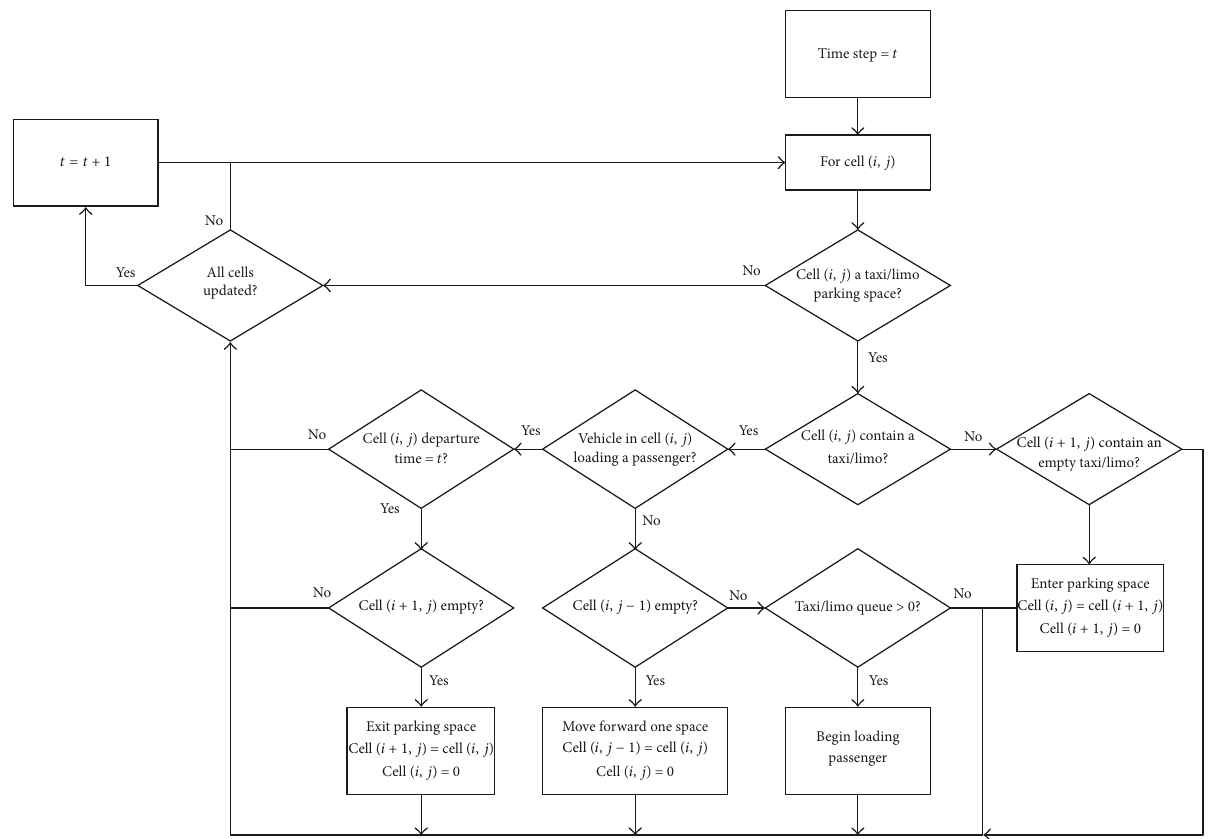
Figure 7: Algorithm for commercial vehicle